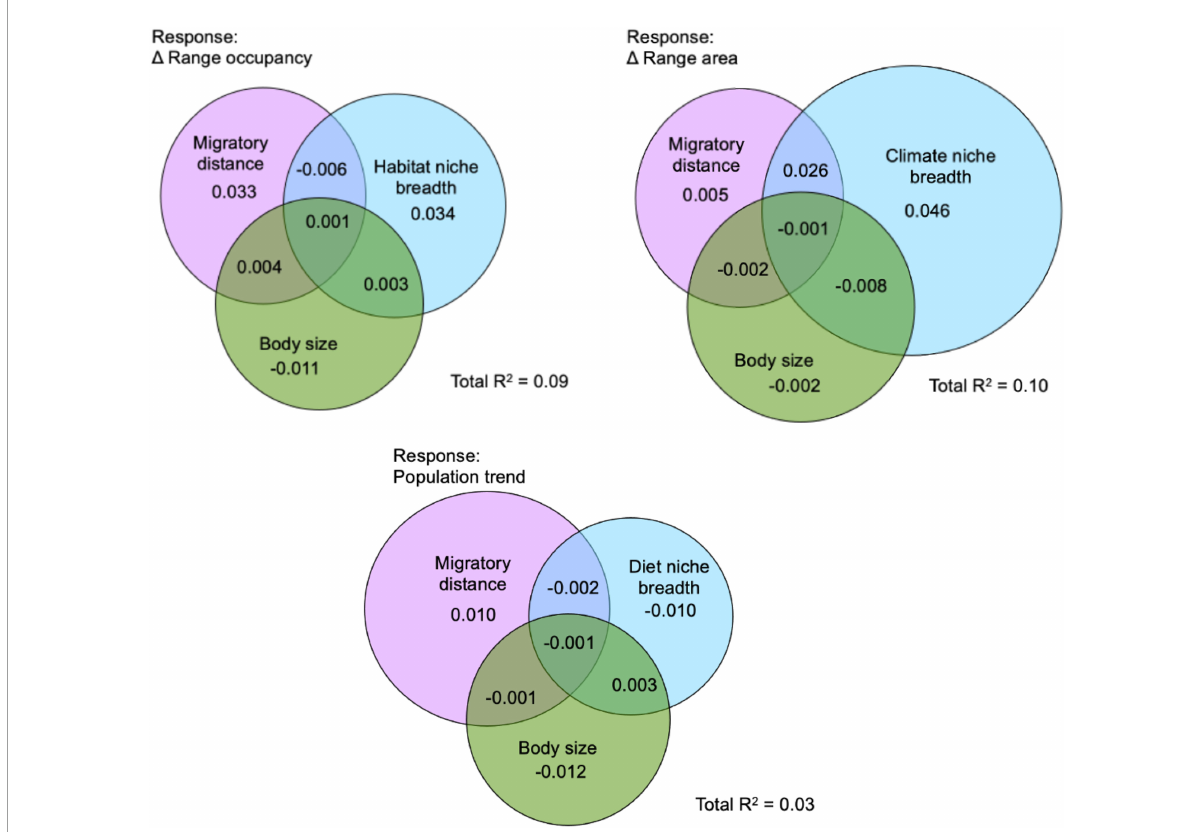
FIGURE5 Variance partitioning of species range shifts explained by species migratory distance, body mass, and the niche breadth axis which showed the strongest effect on the three response variables in a structural equation model. For population trend, diet niche breadth was used. For change in range area, climate niche breadth was used. For change in range occupancy, habitat niche breadth was used. The Venn diagrams indicate unique variance in the responses explained by each of the predictor variables, with overlapping regions showing shared variances. Negative variance partitions can result from correlated